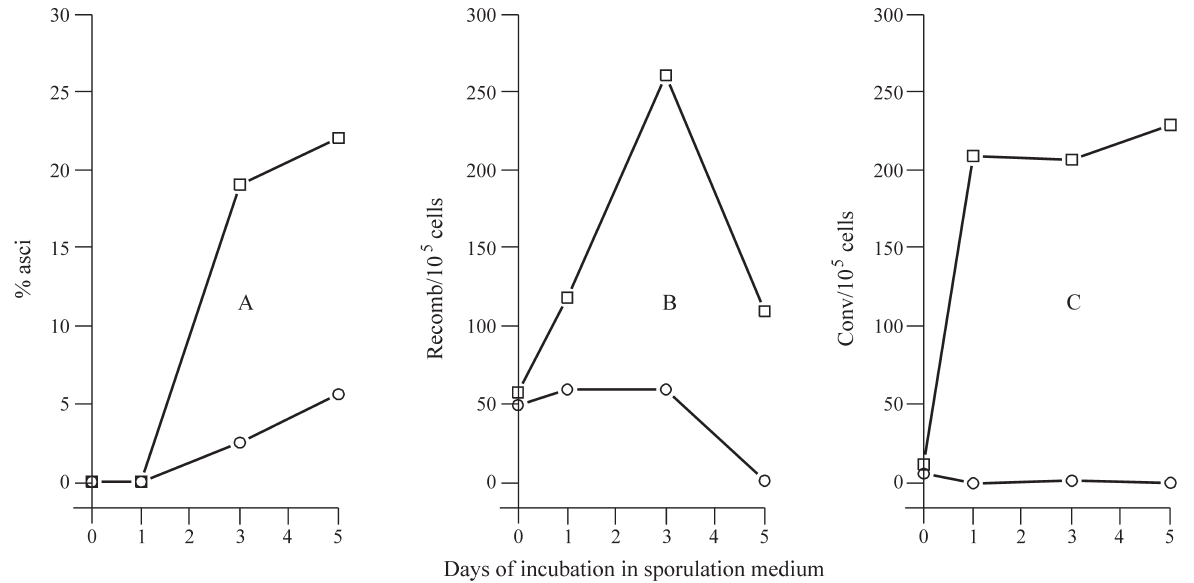
Figure 5 - Frequency of ascospore formation (Figure A), reciprocal recombination (Figure B) and gene conversion (Figure C) of diploid transformants harboring the control pNF2 plasmid ( (cid:1) ) or pNF2 recA plasmid ( (cid:1)